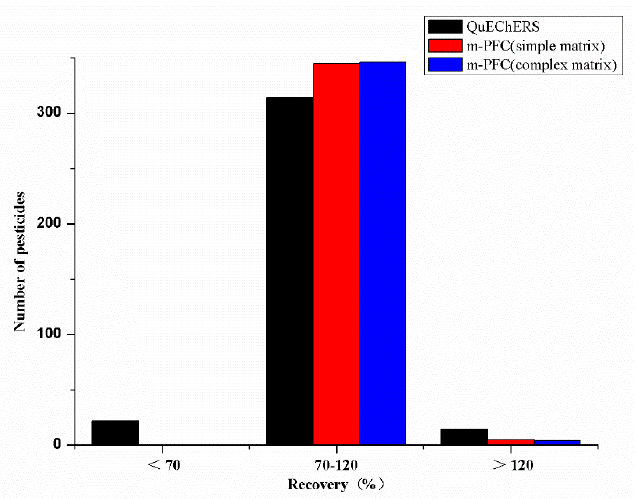
Figure 2. Recoveries of 350 pesticides in the orange juice samples cleaned by differentpurification methods (100 µ methods (100 μ g/kg).